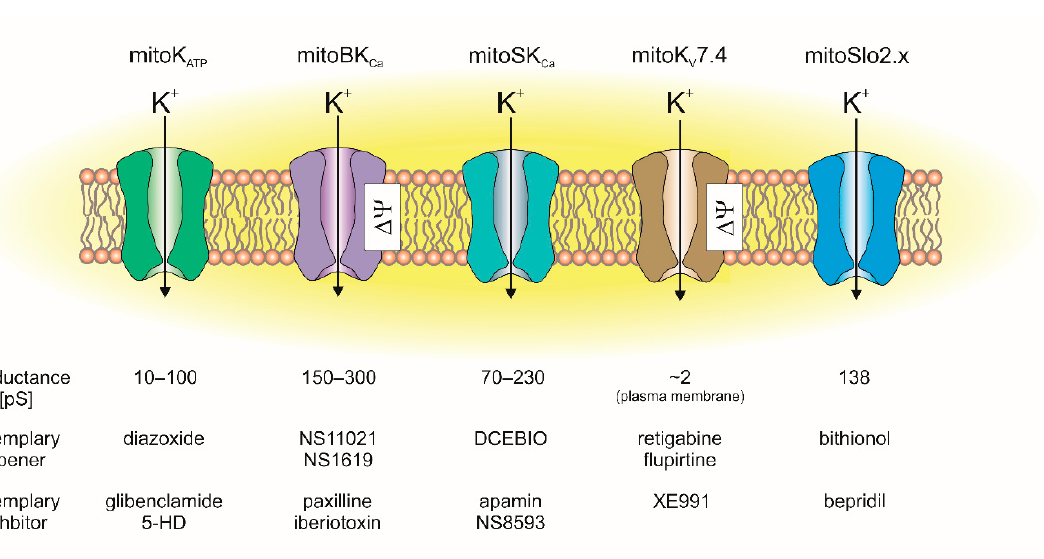
Figure 2. Mitochondrial potassium channels identified in heart tissue: their conductance and exemplary pharmacological tools (channel openers and inhibitors) used in channel characterization.